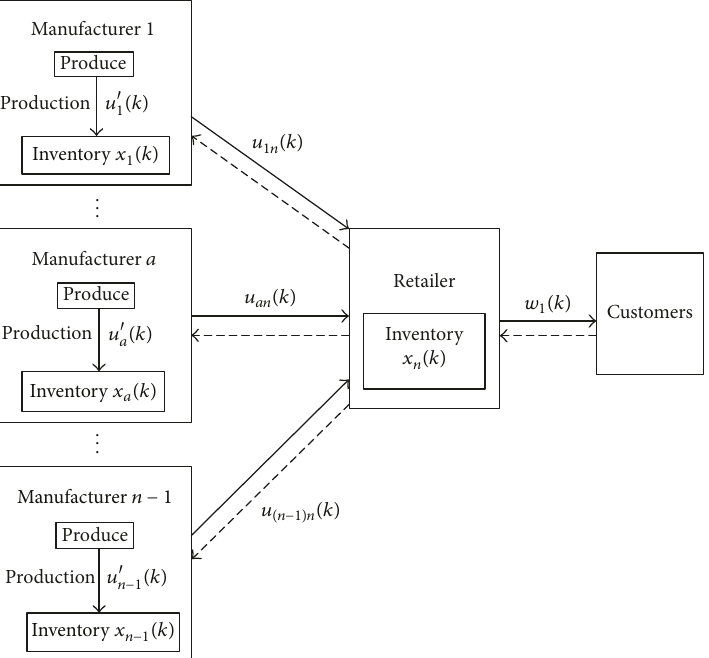
Figure 1: Dynamic supply chain system with lead